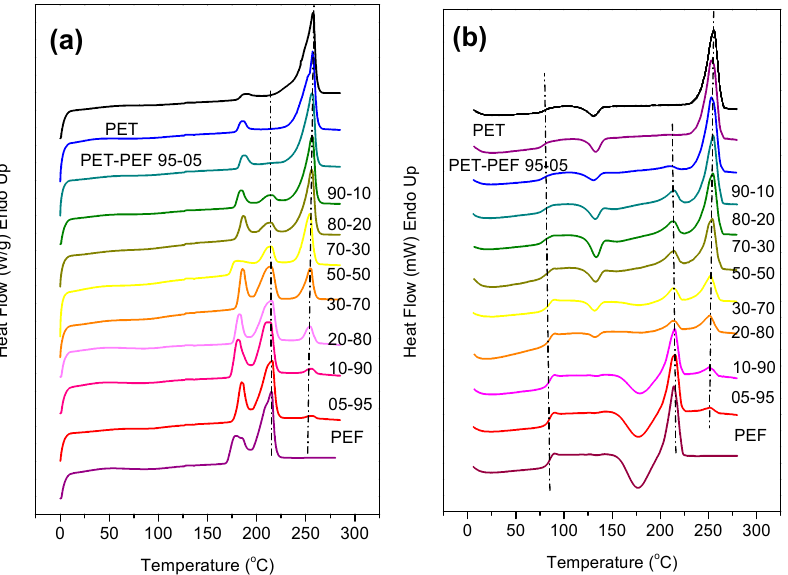
Figure 2. Differential scanning calorimetry (DSC) thermograms ( a ) for the semicrystalline blends recorded upon heating at 20 °C/min and ( b ) total Modulated Temperature DSC (MTDSC) signal for the fast-cooled samples upon heating at 5 °C/min.